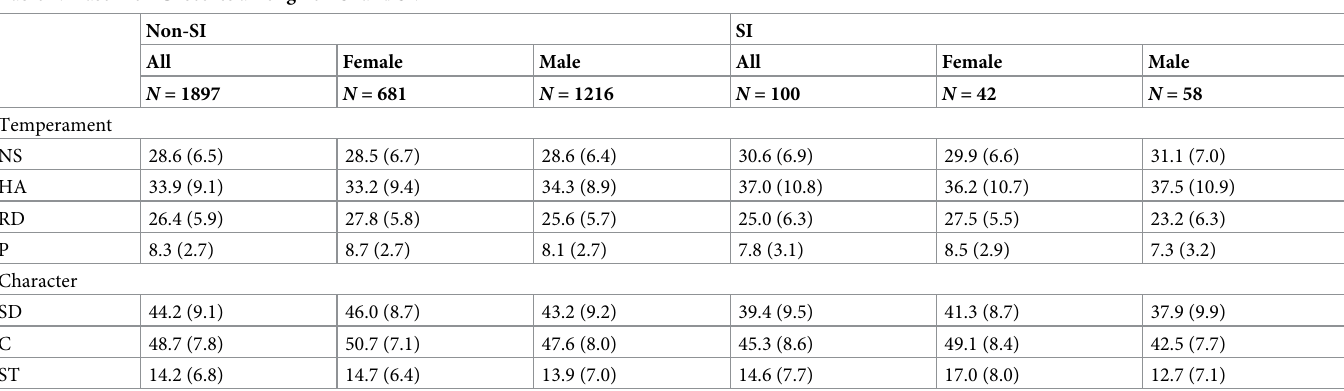
Table 4. Baseline TCI scores among non-SI and